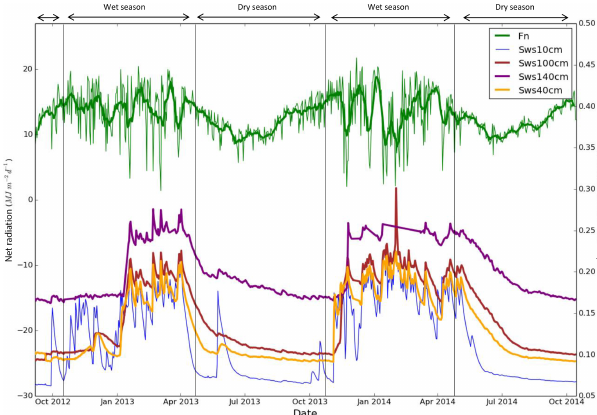
Figure 7. Daily variability in radiation ( F n ) and soil moisture (Sws) at the Howard Springs tropical savanna site, Northern Territory, Australia from September 2012 to October 2014. Mean daily F n is shown with a 10-day running mean (green) to aid in visualisa- tion and daily mean variability in Sws fraction are shown for 10cm (blue), 40cm (orange), 100cm (brown) and 140cm (purple)